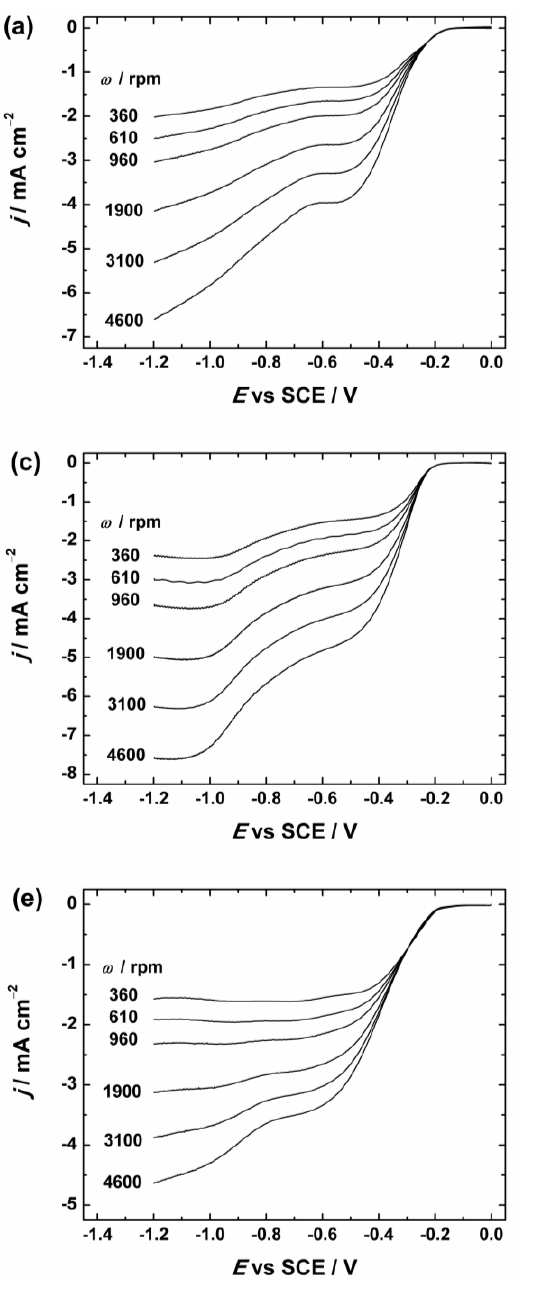
Figure 9. ( a , c , e ) RDE voltammetry curves and ( b , d , f ) Koutecky–Levich plots for O 2 reduction on GC electrodes coated with: ( a , b ) graphene nanopowder (from Graphene Supermarket); ( c , d ) graphene nanoplatelet aggregates (from Strem Chemicals); and ( e , f ) reduced graphene oxide in O 2 -saturated 0.1 M KOH at ν = 10 mV·s −1 . The insets show the potential dependence of n . The electrodes were